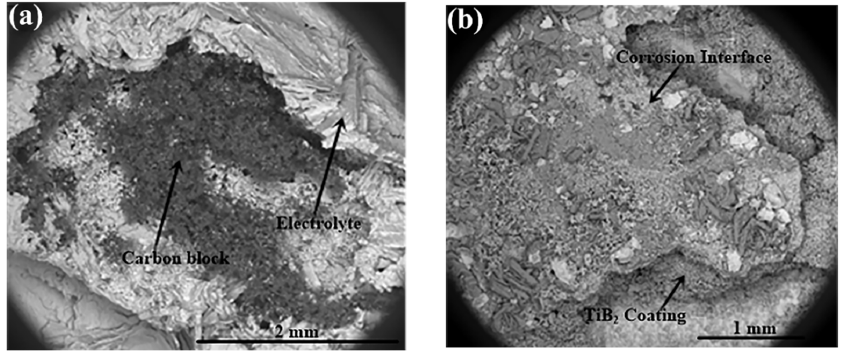
Figure 6. XRD analysis results of TiB 2 coatings before and after erosion in liquid aluminum for around 120 min. ( a ) Before corrosion. ( b ) After corrosion.